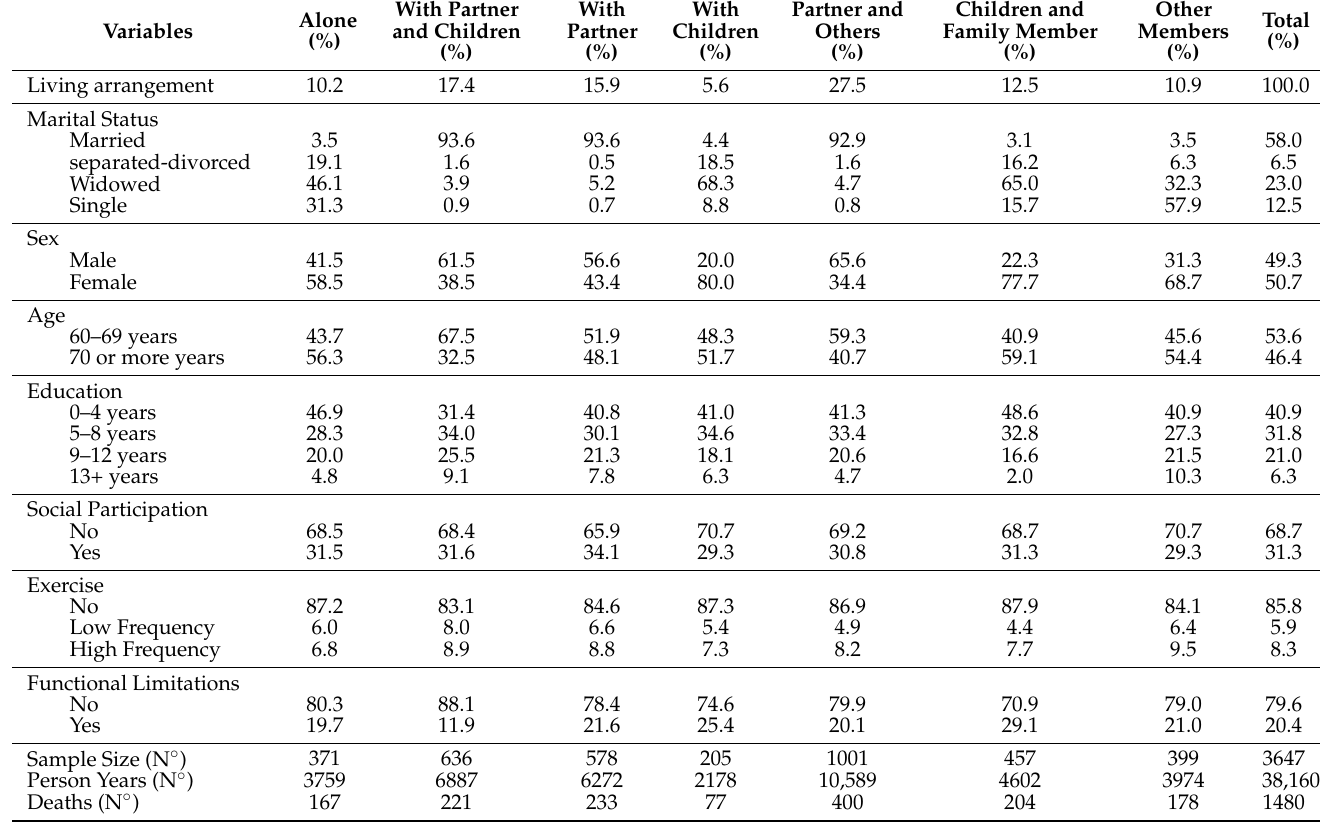
Table 1. Description of the variables in the 2004